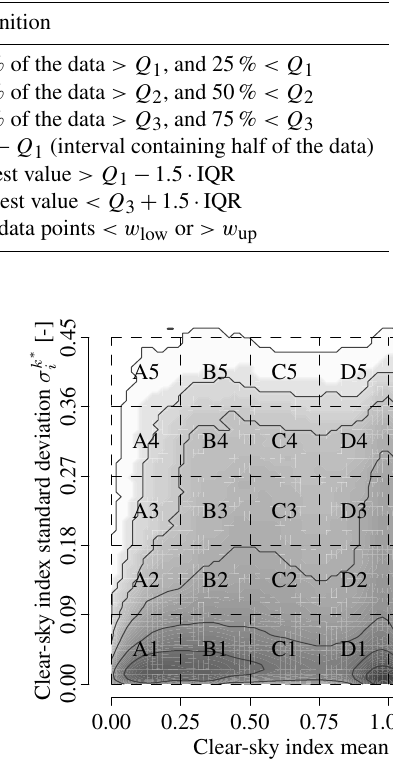
Figure 3. Kernel density estimate (KDE) of the joint probability density function (PDF) of mean k ∗ i and standard deviation σ k clear-sky index, based on all available single-sensor data from both measurement campaigns. The overlaid regular grid is used to define particular sky type